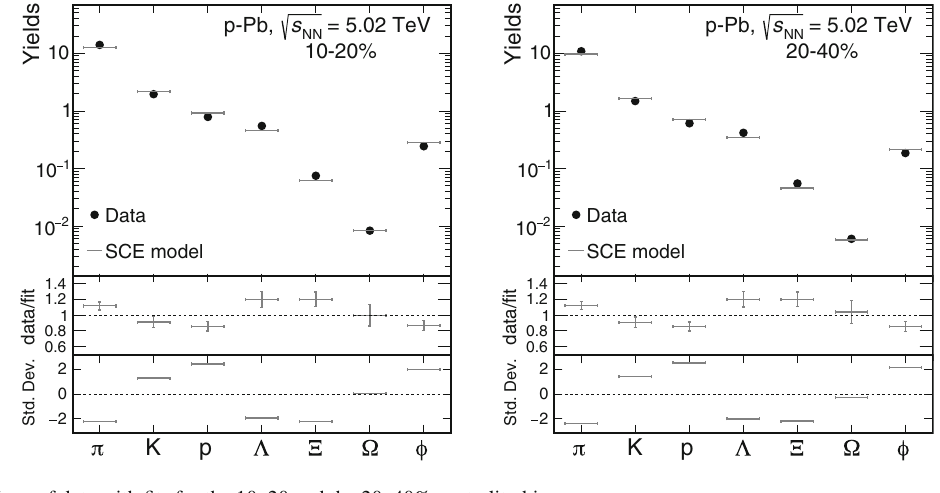
Fig. 3 Comparison of data with fits for the 10–20 and the 20–40% centrality bins